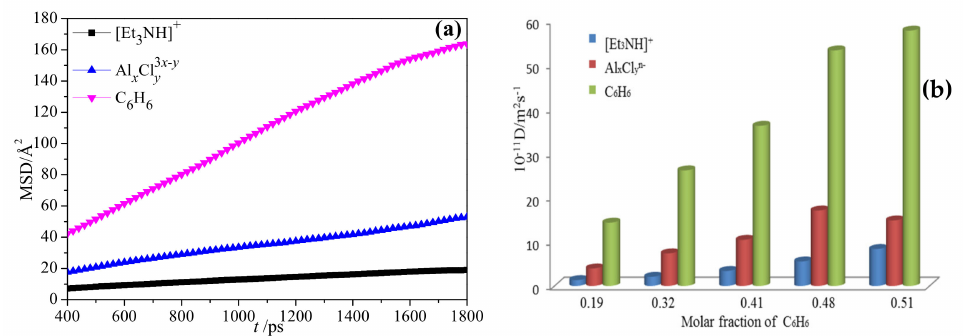
Figure 4. ( a ) MSD (x AlCl3 = 0.19) and ( b ) the diffusion coefficient of each ion in [Et 3 NH]Cl/AlCl 3 with different mole fraction of C 6 H 6 from molecular dynamics